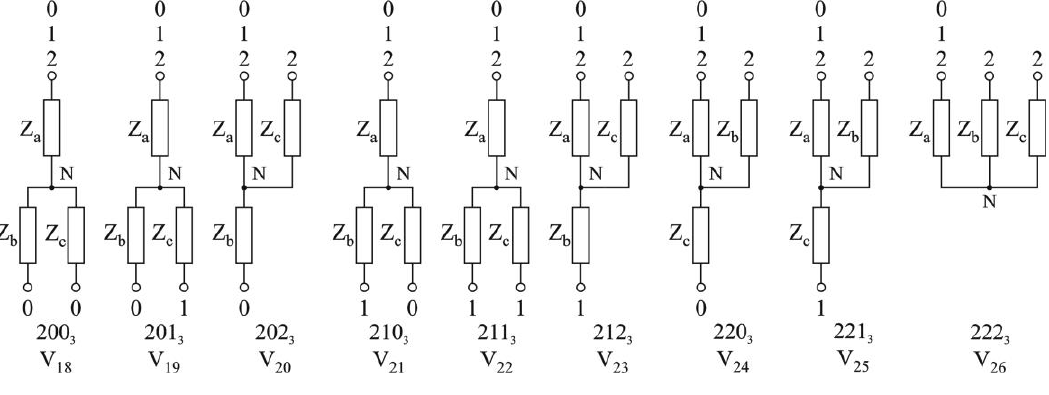
Table 1. All currents corresponding to all vector states of the three-level inverter.